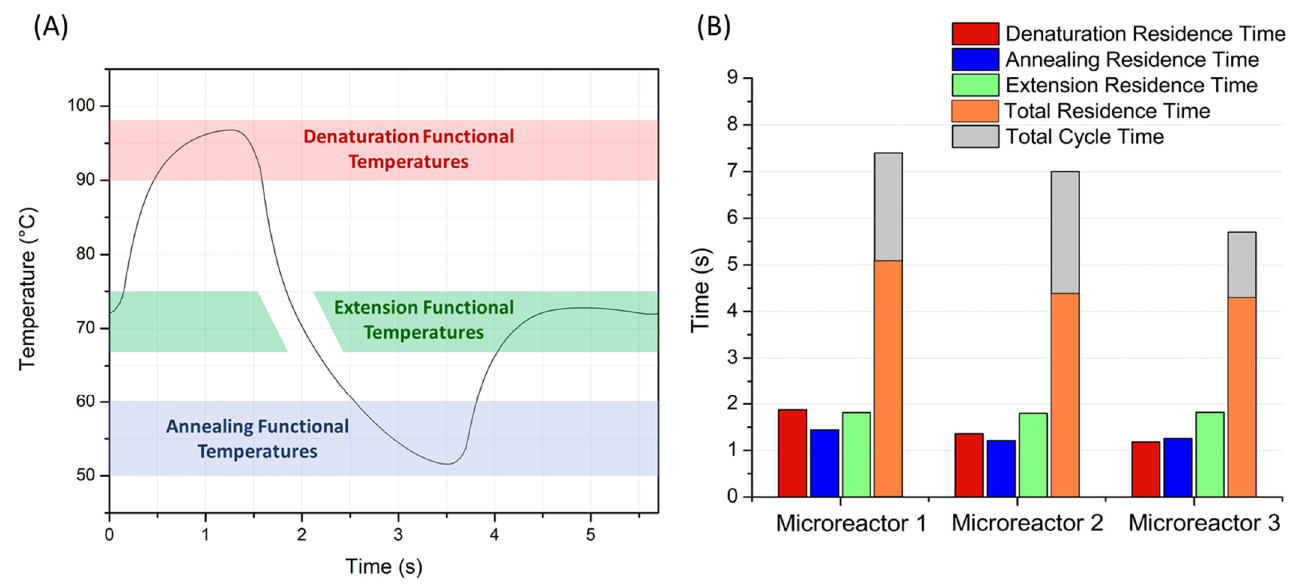
Figure 6. ( A ) Temperature profile taken at the middle of the microchannel, as a function of time, for the third microreactor geometry (representative case). The colored areas show the functional temperature ranges, where the three PCR steps can take place efficiently. ( B ) Residence times and total cycle times for the three microreactor geometries.